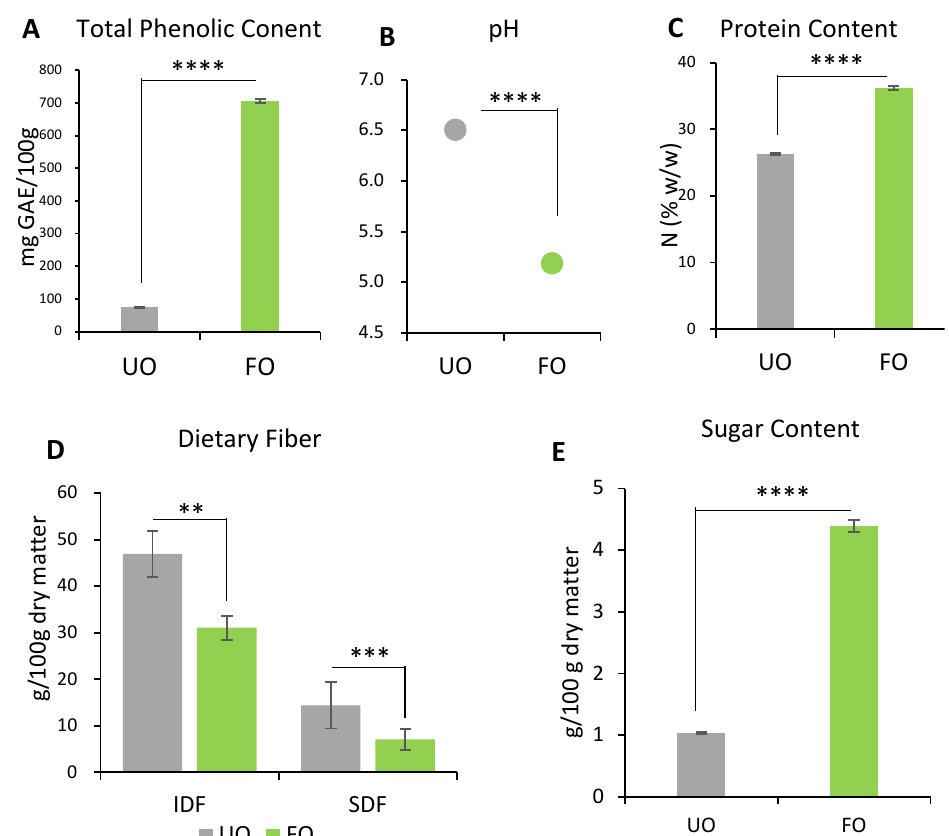
Figure 1. The nutritional profile of unfermented okara (UO) and fermented okara with Aspergillus spp. (FO). The TPC ( A ), pH ( B ), protein content ( C ), IDF and SDF ( D ), and total sugar content ( E ) were measured. Data are represented as mean ± SEM ( n = 3). ** p < 0.01, *** p < 0.001, and **** p < 0.0001 evaluated using Student’s t -test.